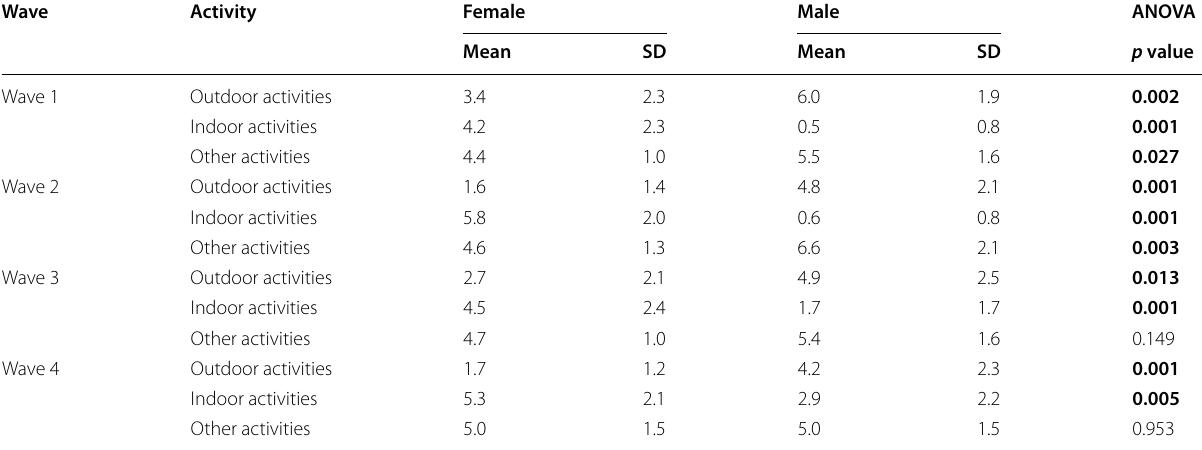
P value < 0.05 are shown bold